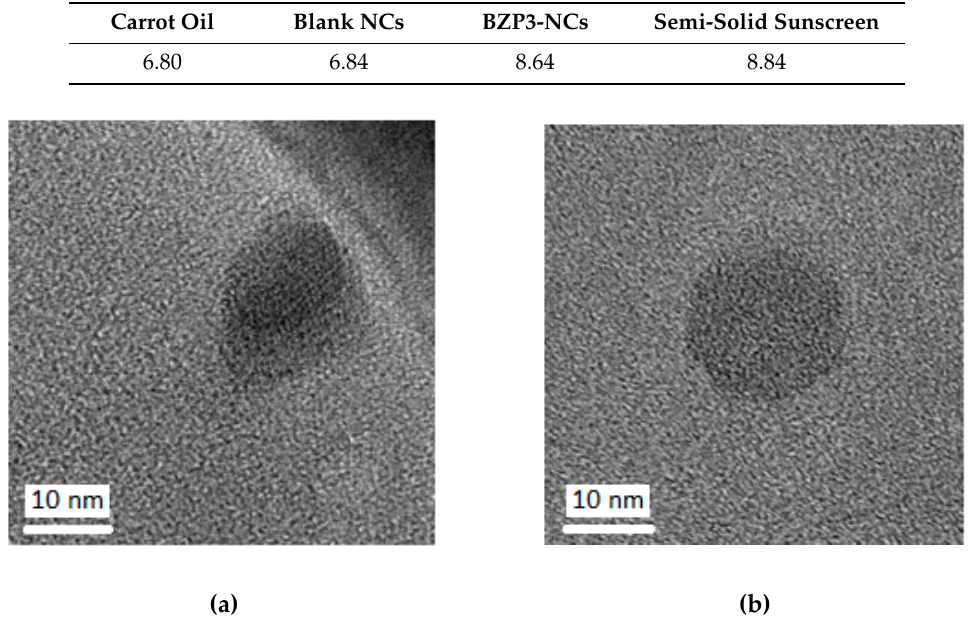
Table 3. Sun protection factor (SPF) of carrot oil, blank NCs, BZP3-NCs, and semi-solid sunscreen.